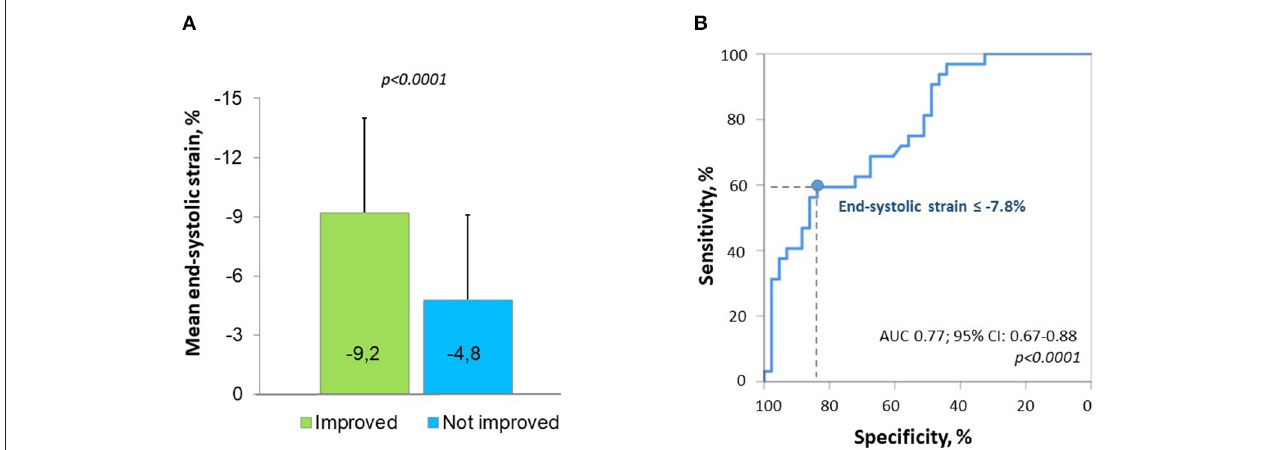
FIGURE 2 | Preoperative segmental longitudinal end-systolic strain of left ventricular (LV) basal segments with initial hypo- or akinesia according to the improvement in segmental wall motion at follow-up (A) and the receiver operating characteristic (ROC) curve for predicting an improvement in regional wall motion by preoperative strain (B) .